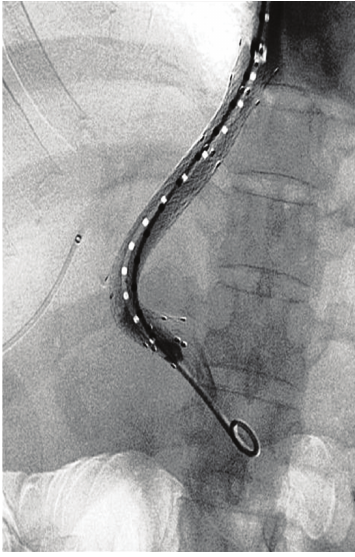
Figure 10: Successful TIPS placement after portal vein catheteriza- tion by a transjugular